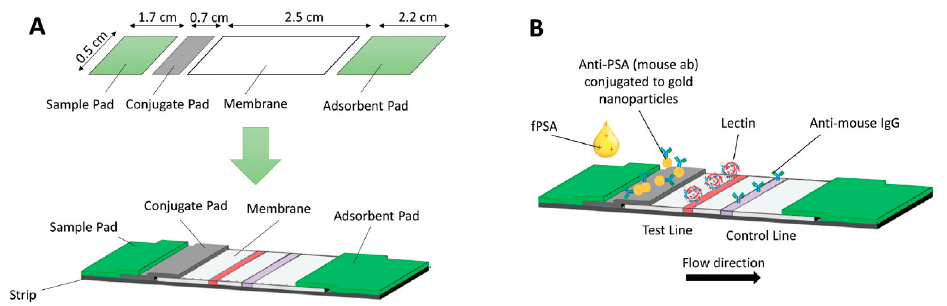
Figure 11. Lectin-based lateral flow assay test design. ( A ) Components required for the construction of a lectin-based strip. ( B ) Depiction of a lectin-based test strip. Reprinted from ref. [190]. Copyright (2016) with permission from Royal Society for Chemistry.